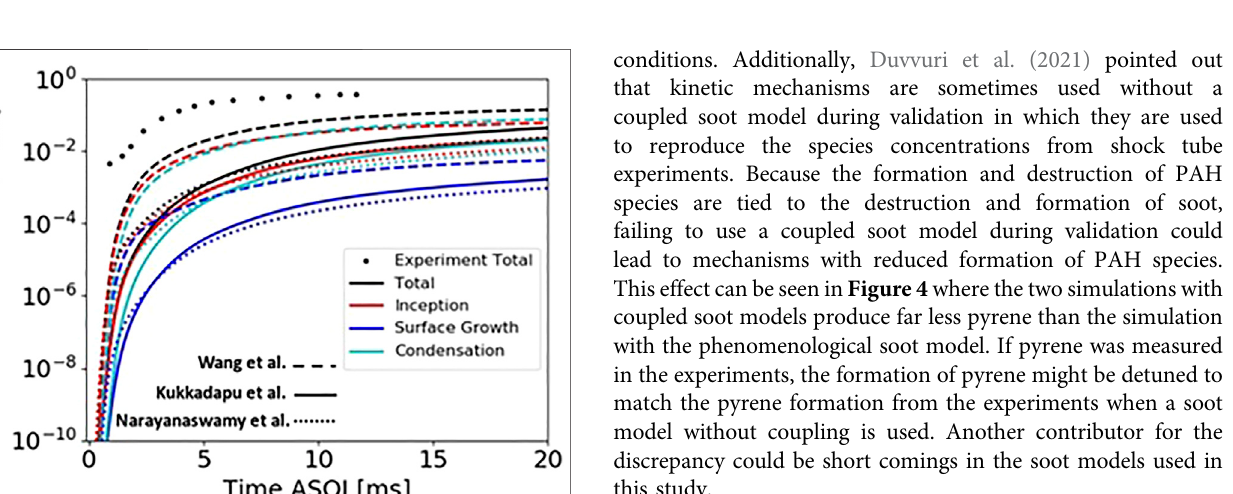
Frontiers in Mechanical Engineering |